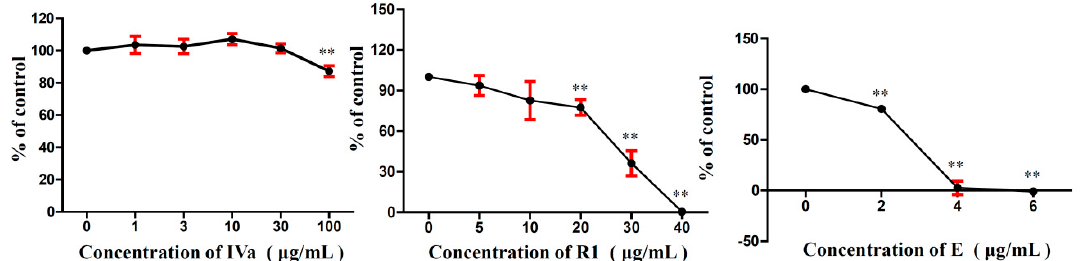
Figure 6. Effects of IVa, R1, and E on B16F10 melanoma cells in vitro. The results of the control (0 μ g/mL) were normalised to 100%, and the results from treated cells were expressed as % of the control (* p < 0.05, ** p < 0.01).